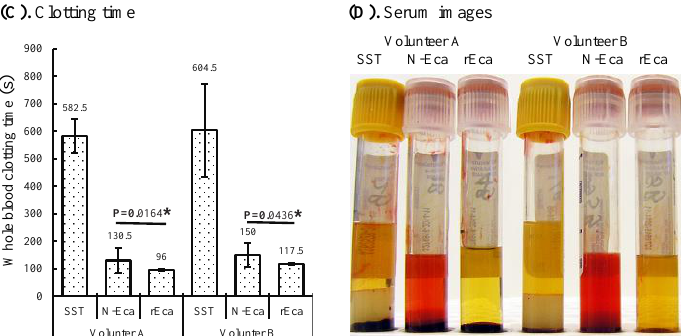
Figure 2. Characterization of rEcarin and N-Ecarin in clotting recalcified citrated whole blood and fresh whole blood. The activity of N-Ecarin and rEcarin in clotting both recalcified citrated whole blood and fresh whole blood. ( A ) Established standard curves of N-Ecarin and rEcarin when clotting 2 mL of recalcified citrated whole blood. ( B ) Image of serum generated by N-Ecarin and rEcarin showing that higher concentrations of N-Ecarin (0.16 and 0.24 mU) caused obvious hemolysis during blood clotting. The blood clots generated by 0.04, 0.08, 0.16 and 0.24 mU/tube showed clot retraction. ( C ) Activity of N-Ecarin and rEcarin (0.16 mU/Tube) when clotting fresh whole blood from two volunteers, compared with that of BD SST tube only, in duplicate ( n = 2). Fisher’s exact test revealed that the clotting times generated by rEcarin were significantly shorter than those for N-Ecarin * p < 0.05. ( D ) Images of serum from the fresh whole blood of two volunteers clotted by BD SST tube, N-Ecarin- and rEcarin-containing red top plain tubes. N-Ecarin caused severe hemolysis during blood clotting.